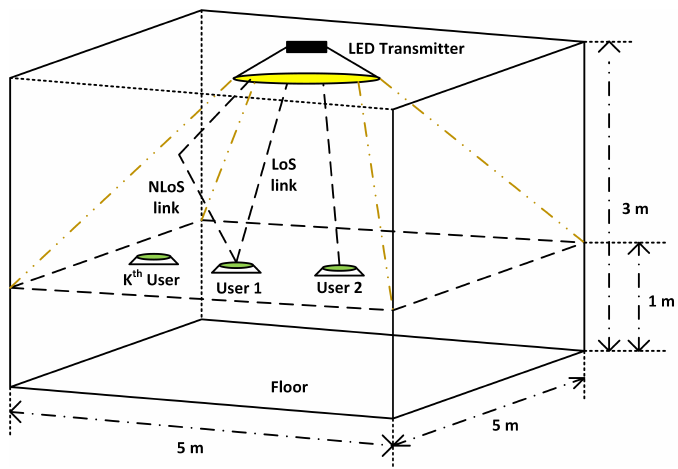
Figure 7. VLC Channel for Multi-Users